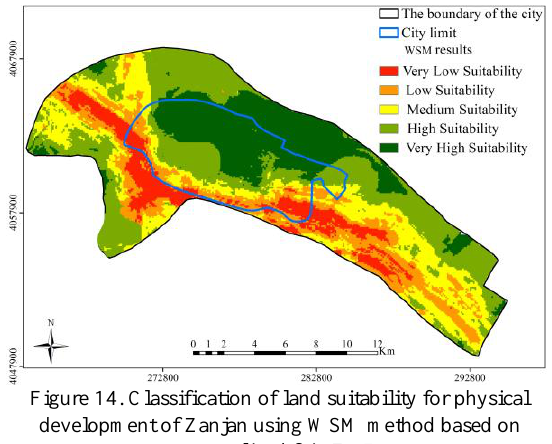
Figure 14. Classification of land suitability for physical development of Zanjan using WSM method based on normalized S in Eq.7 Table 3. The results of the TOPSIS and WSM methods in the case of the sub-criterion of distance from